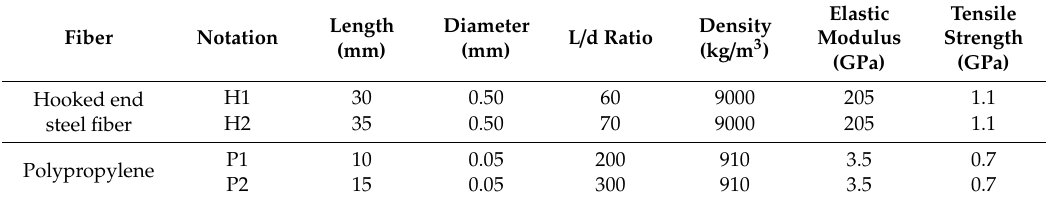
Table 3. Properties of fibers.